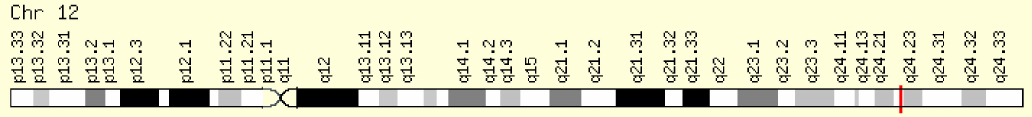
Figure 2. Localization of the NOS1 gene